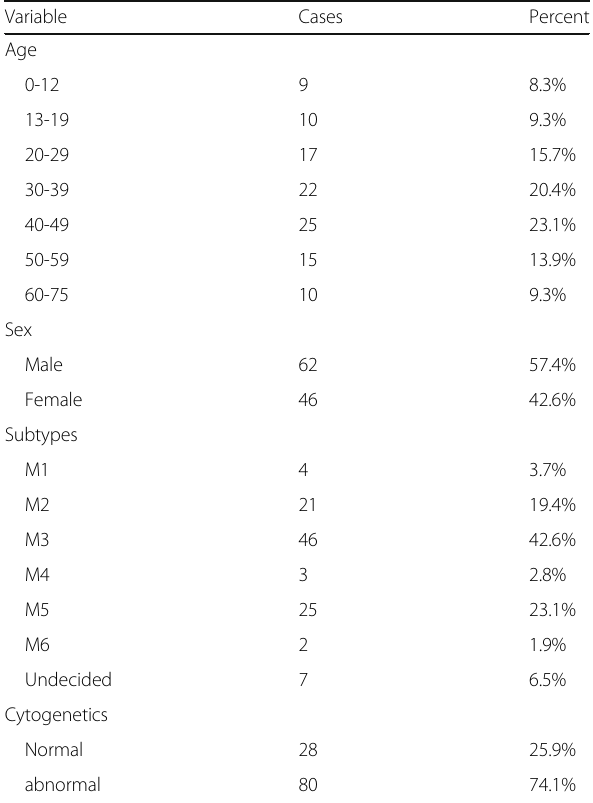
(Table 2) using a Leukemia Related Fusion Gene Detection Table 1 Clinical characteristics of 108 patients with AML